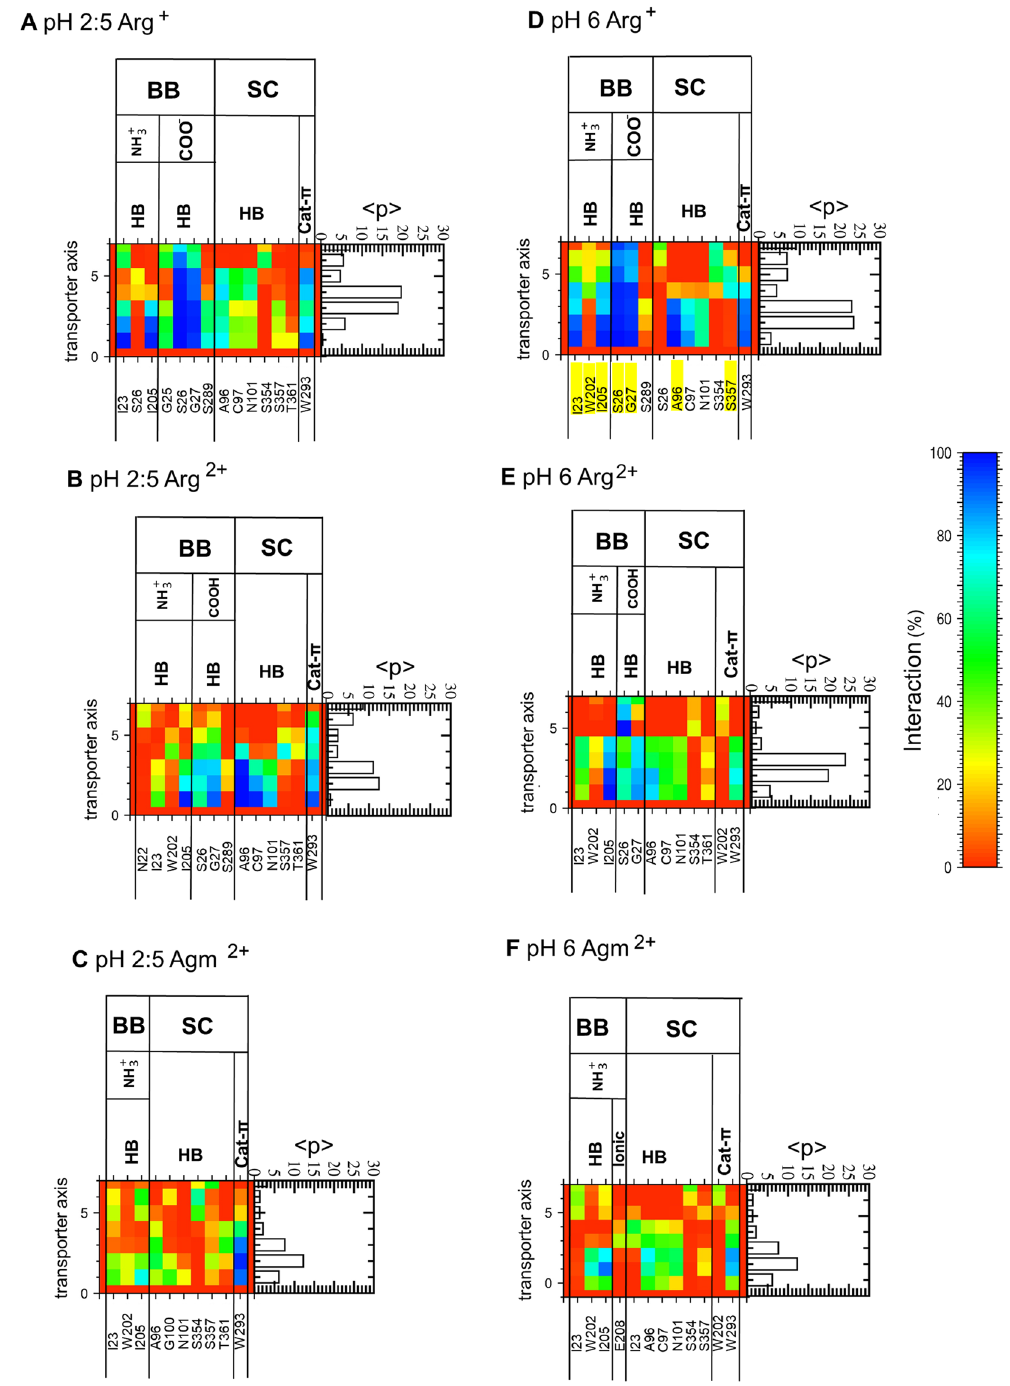
Figure 4. Interactions formed by the ligands in the binding site. H bonds, ionic and cation- π interactions formed at pH 2:5 ( A – C ) and pH 6 ( D – F ) between the Arg + ( A , D ), Arg 2 + ( B , E ), or Agm 2 + ( C , F ) backbone (BB) or sidechain (SC) and protein residues (both BB and SC) in the classical MD simulations. A bar graph of the percentage of the simulations during which the ligands are observed at each transporter axis value is also shown on the right side of the interaction charts. Results are shown for the 12 monomers of the 6 classical MD trajectories. Only interactions occurring in more than 20% of the conformations in at least one bin are shown. Observed interactions between the Arg ligand and the protein residues in the OF open crystal structure are highlighted in yellow in figure ( D ) (PDB ID: 3OB6, Monomer A; Table